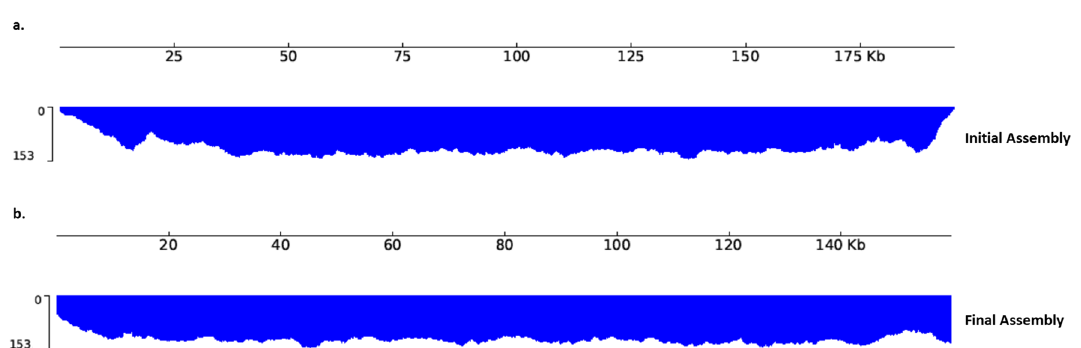
Figure 1. Read mapping coverage of genome assemblies for a. the initial Flye assembly and b. the final polished assembly. Read coverage was found to be more uniformly distributed in the final assembly in comparison to the initial assembly (Flye assembly using > 3000 Viral DNA Read Set), which was found to have uneven read coverage distributions at the contig ends. This is indicative of the final polished assembled containing terminal repeat sequence lengths that more closely match that of the ground truth.